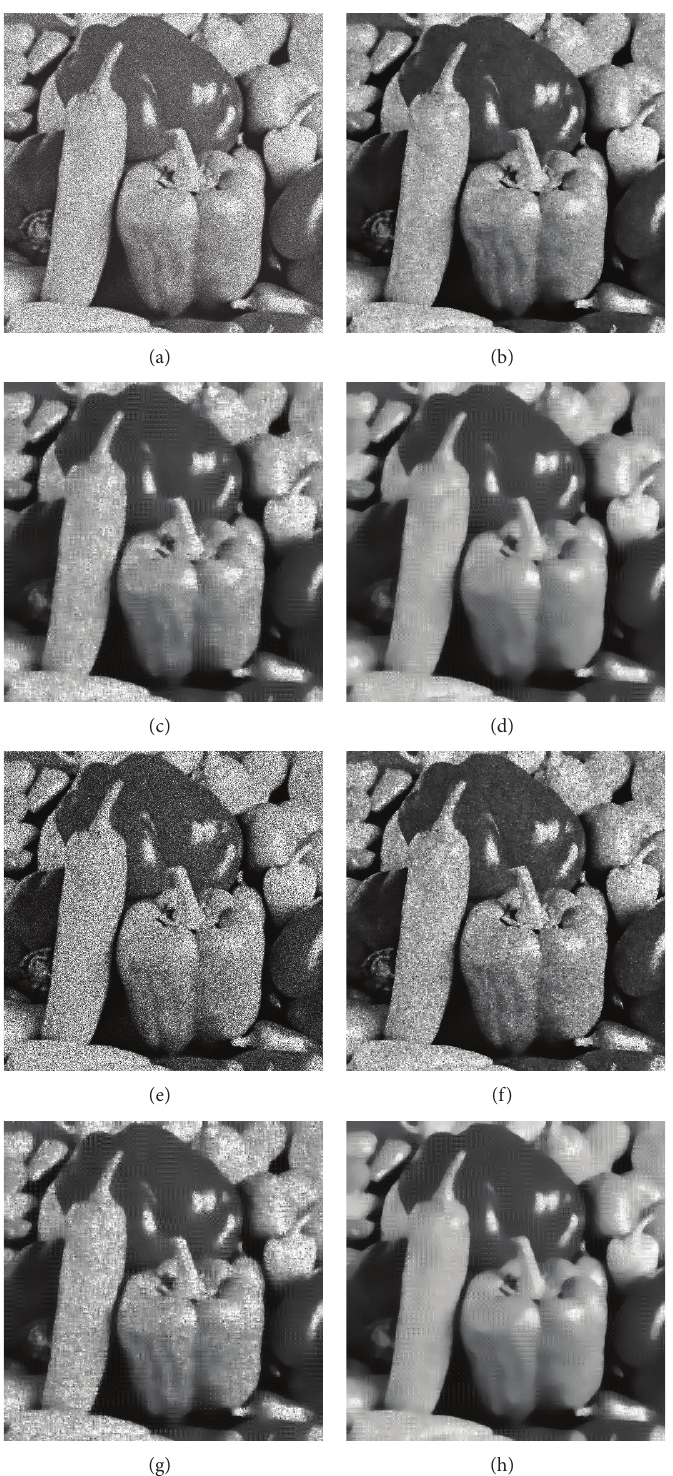
Figure 1: Images restored using various methods, images of “peppers”: (a) and (e): noisy images with mean 1, noise variances 0.1 and 0.2, and Gaussian blurs with kernel spread of 3 & 4, respectively; (b) and (f) restored using RLO method [10]; (c) and (g) restored using AA filter [8]; (d) and (h) restored using the proposed